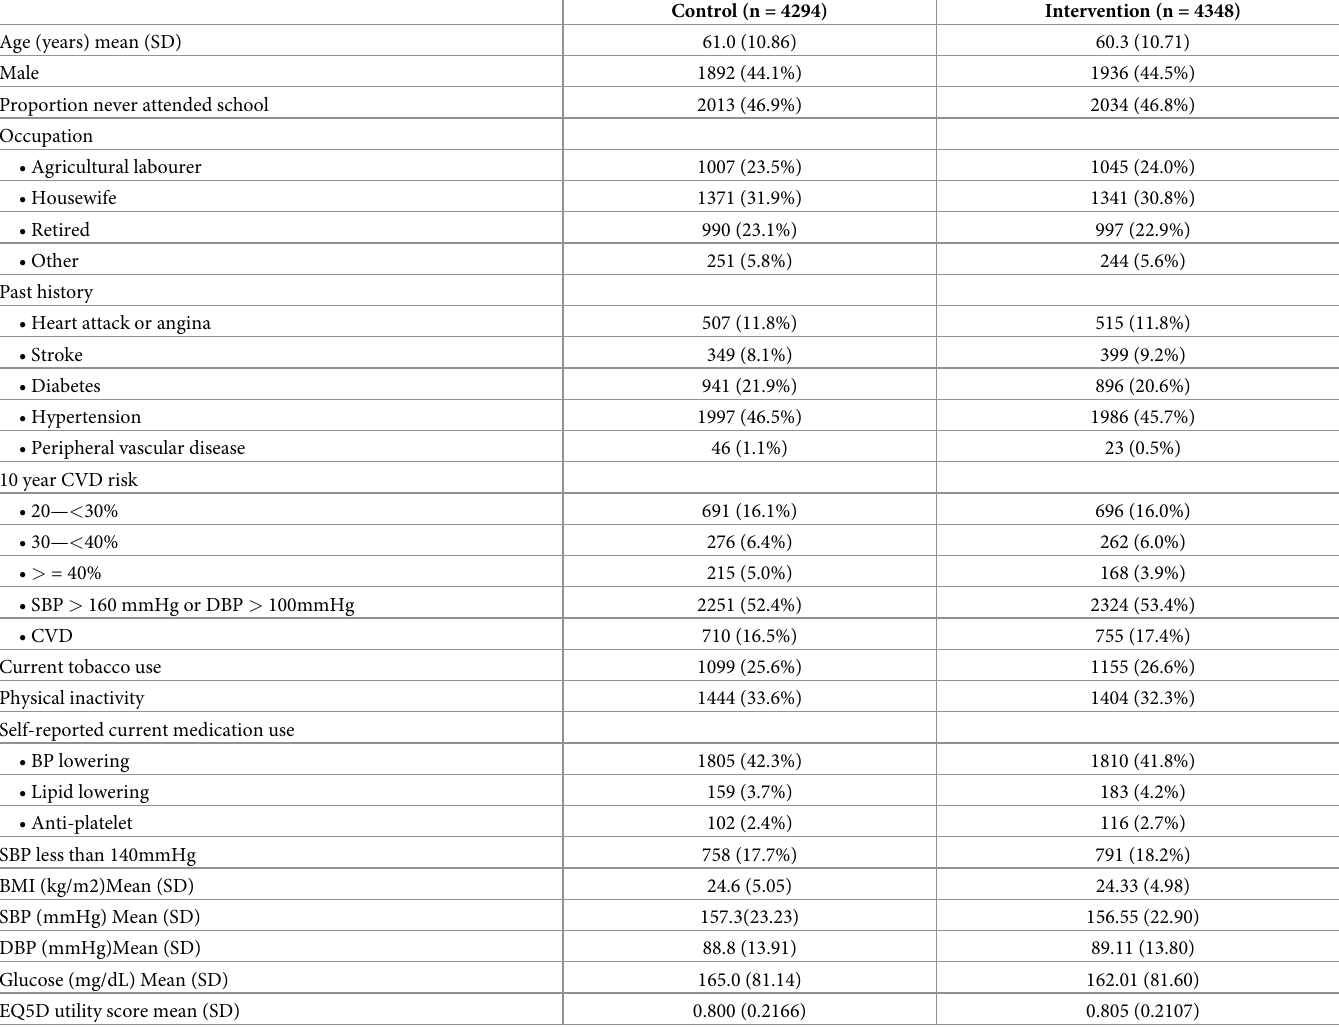
Table 2. Baseline characteristics for patients followed up in the control and intervention periods �